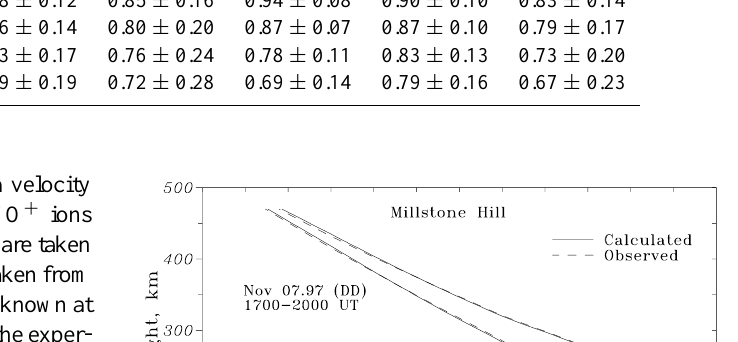
Table 4. Observed seasonal variation of the rNe values at F1-layer heights for Millstone Hill and EISCAT. Average daytime values along with standard deviations are given Height Millstone Hill EISCAT km Winter Spring Summer Autumn Spring Summer Autumn 160 0.99 ± 0.27 0.92 ± 0.15 0.99 ± 0.12 0.90 ± 0.12 1.00 ± 0.13 0.93 ± 0.12 0.86 ± 0.11 170 0.92 ± 0.24 0.86 ± 0.14 0.98 ± 0.12